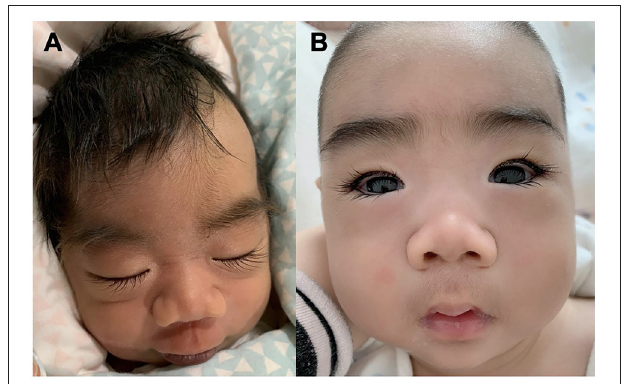
FIGURE 1 | Facial Gestalt of the Patient #1 with de novo KCNT2 variant (A) at birth and (B) at the age of 3 months.